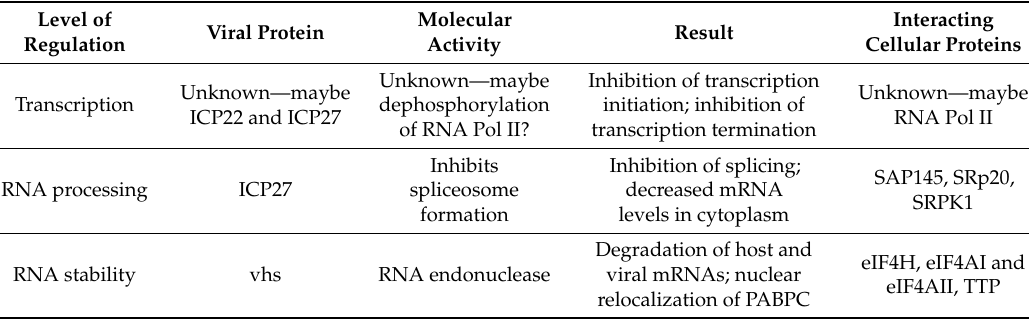
Table 1. Host shutoff mechanisms in HSV-1 and